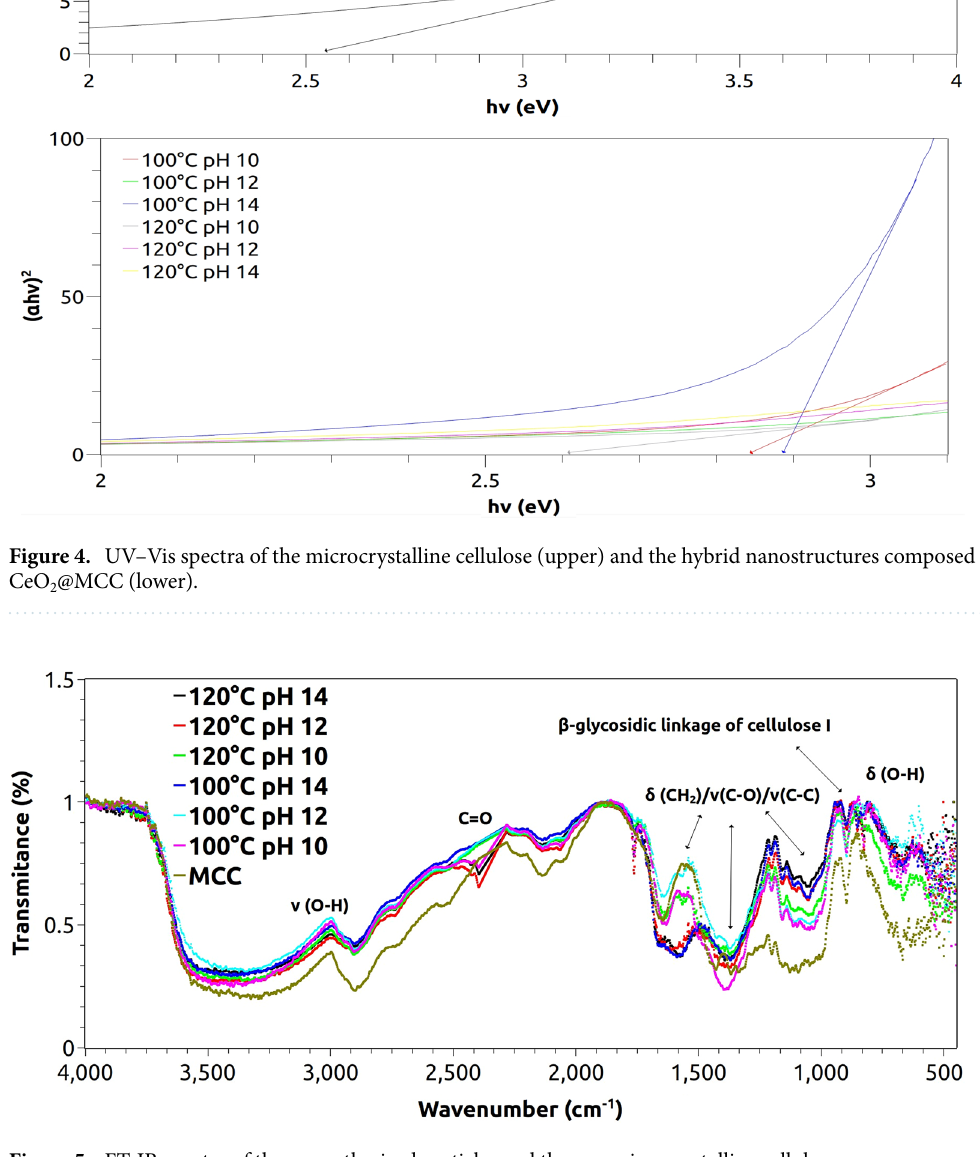
Figure 5. FT-IR spectra of the as-synthesized particles and the raw microcrystalline